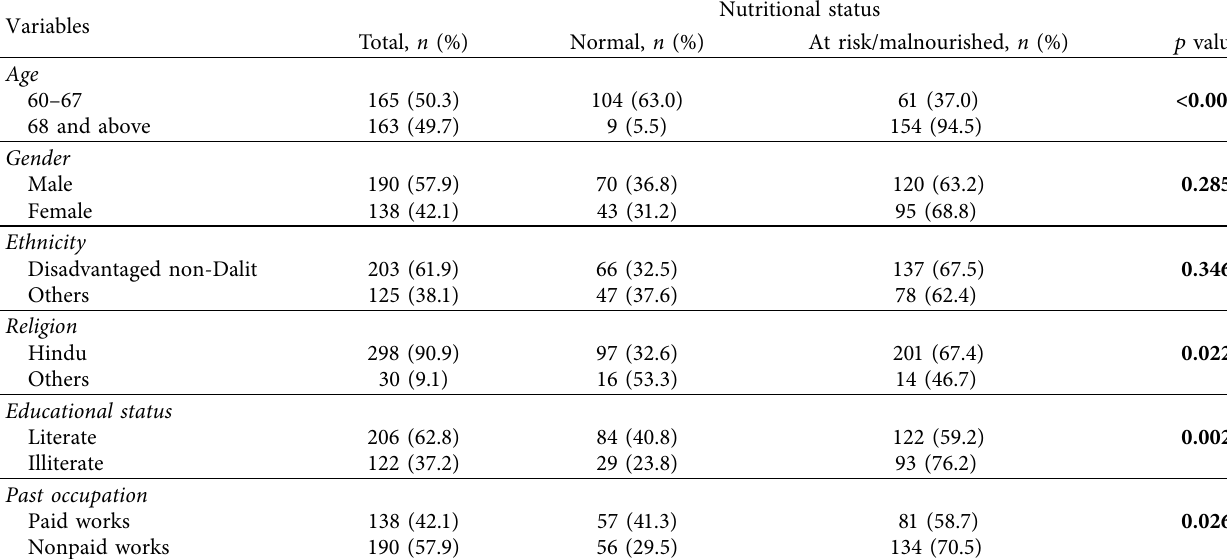
Table 2: Association between sociodemographic variables and nutritional